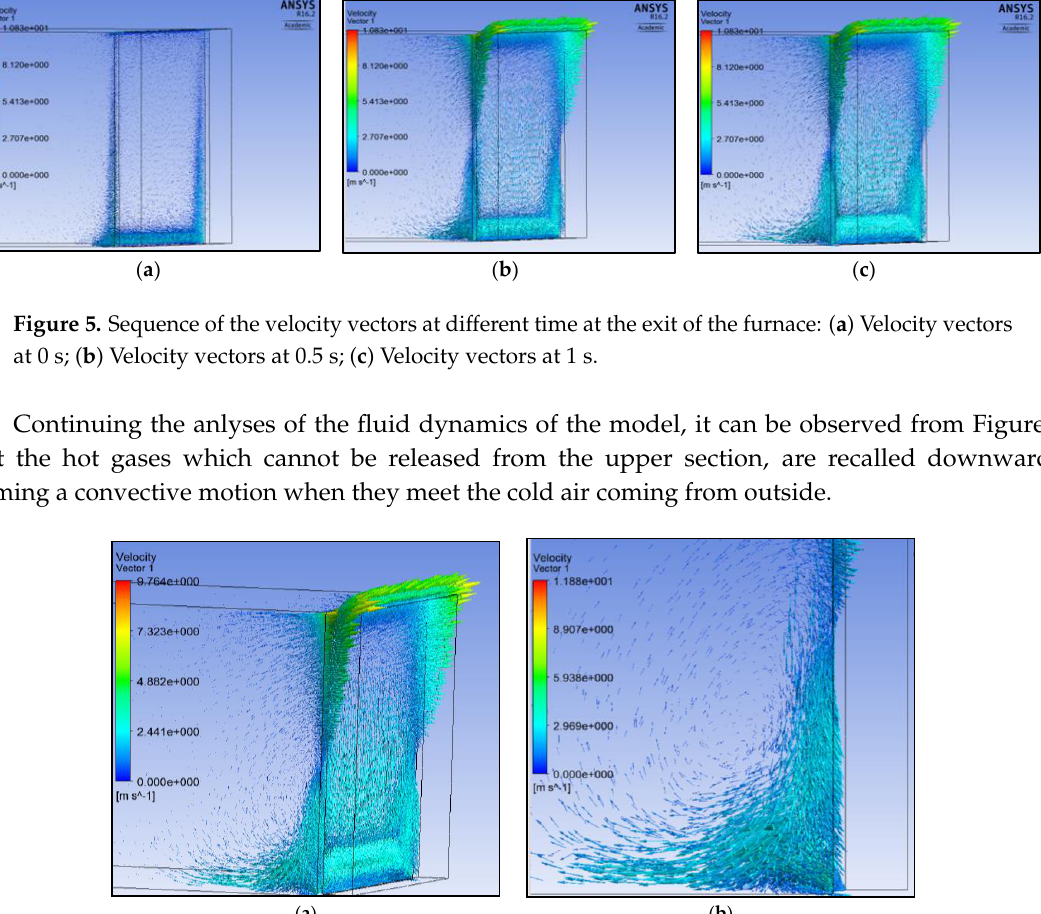
Figure 4. The trend of the maximum temperature reached in the surface B and C during the 157 s of the door opening.